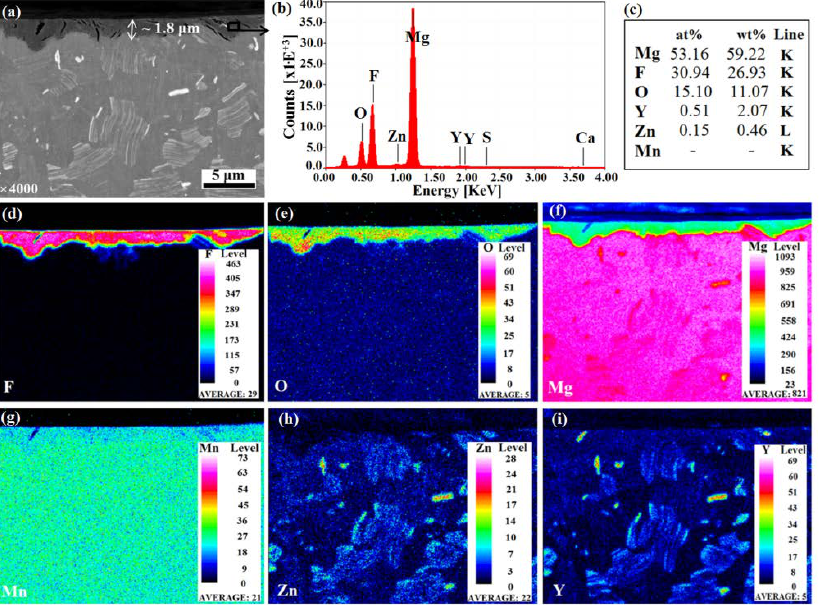
Figure 5. SEM analysis of a cross-sectioned MgF 2 -coated sample ( a ); WDX spectrum ( b ) and elemental compositions ( c ) of the coating (black square of ( a )); maps of elemental distribution ( d – i ). This analysis was performed at ZeLMI, TU Berlin.